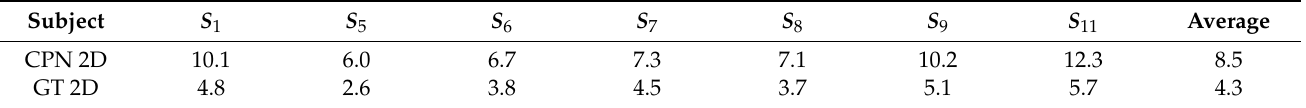
Table 4. Results of bone length recovery